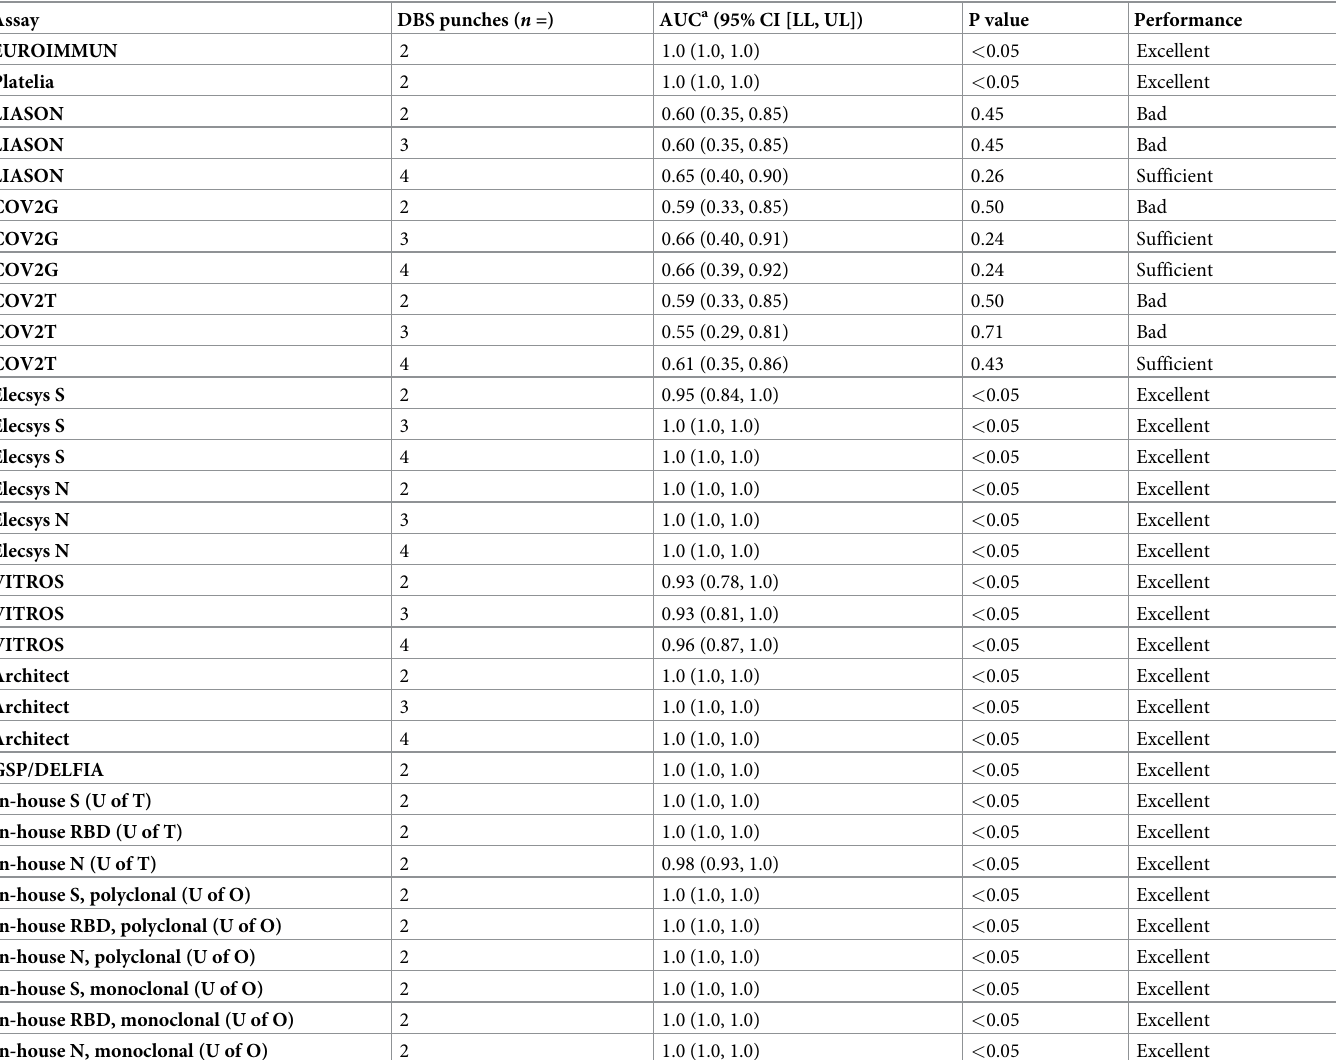
Table 2. Area under the receiver operating characteristic curve (AUC) for each commercial and in-house assay on dried blood spot specimens (DBS).